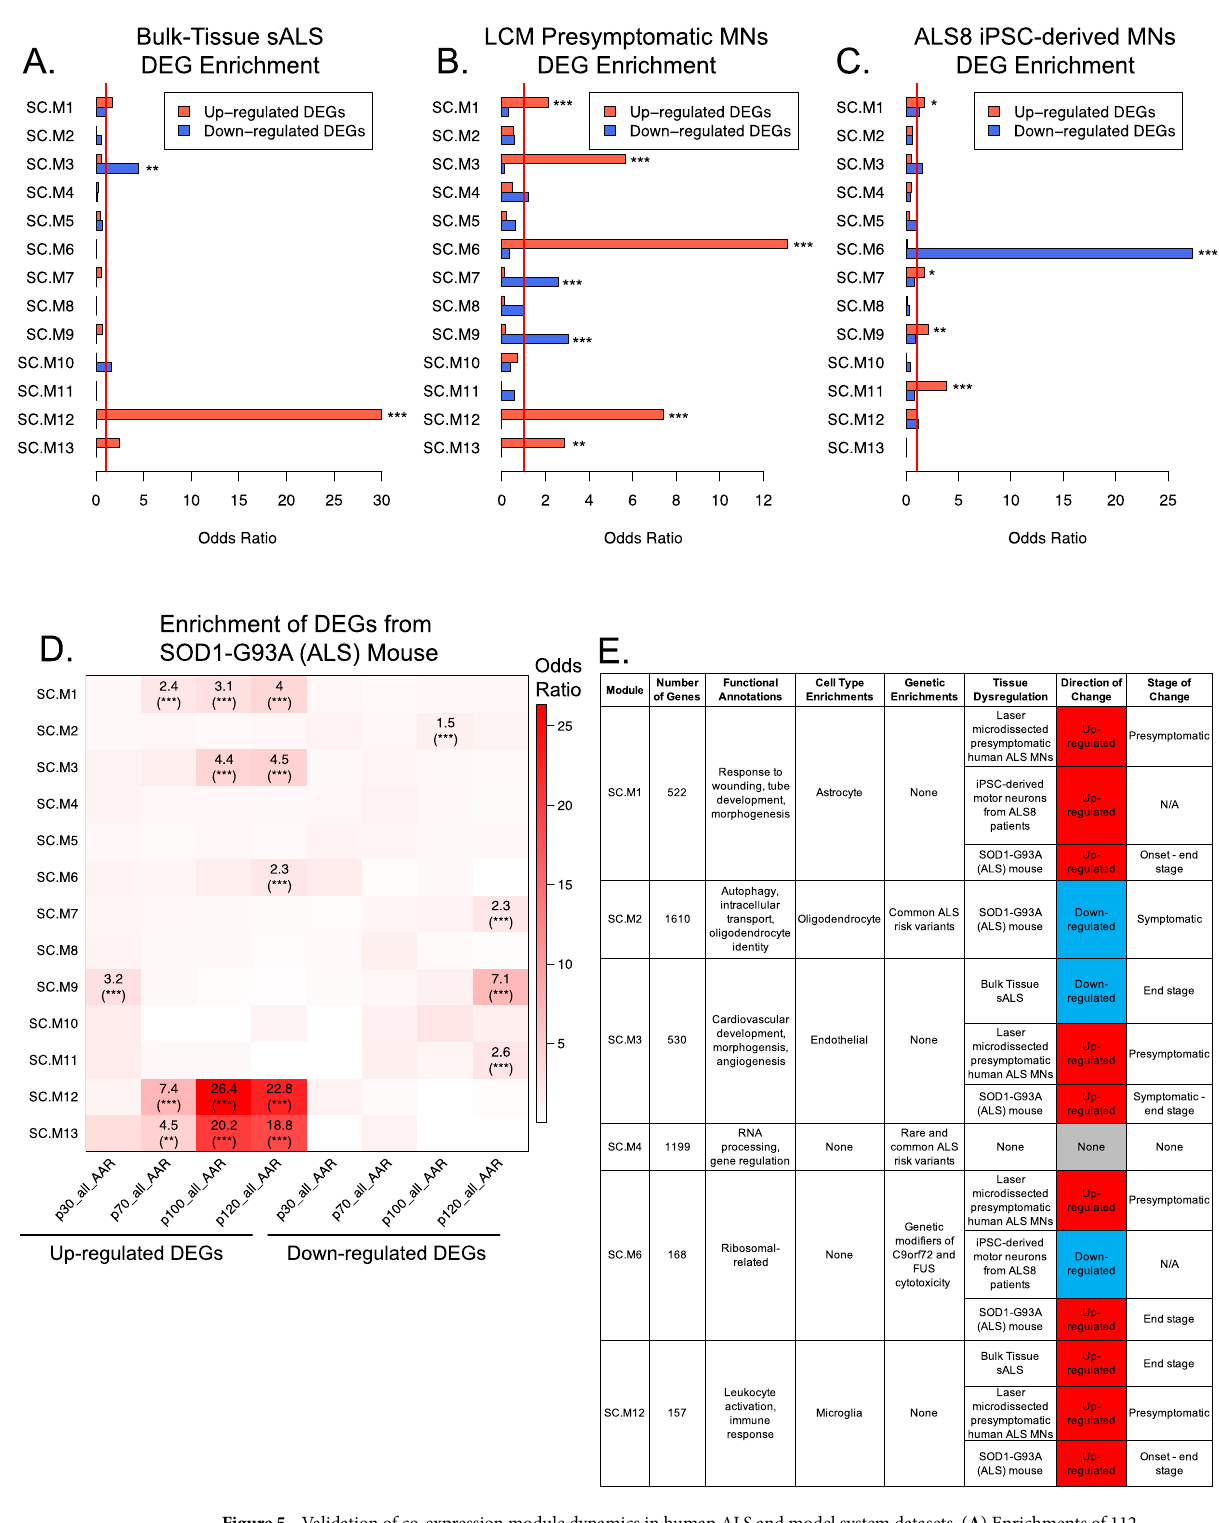
Figure 5. Validation of co-expression module dynamics in human ALS and model system datasets. ( A ) Enrichments of 112 up-regulated and 70 down-regulated DEGs from bulk-tissue RNA-sequencing of postmortem ALS cervical spinal cord 13 within co-expression modules. Red line marks a baseline odds ratio of 1. * (FDR corrected p-value < 0.05). ** (FDR corrected p-value < 0.01). *** (FDR corrected p-value < 0.001). ( B ) Same as ( A ) except for using 1290 up-regulated and 310 down-regulated DEGs from RNA-sequencing of laser capture microdissections of motor neurons primed for degeneration 22 . ( C ) Same as ( A ) except for using 364 up-regulated and 289 down-regulated DEGs from RNA-sequencing of iPSC-derived motor neurons from ALS8 patients 23 . ( D ) Enrichment of DEGs within each disease stage of the SOD1-G93A mouse 12 within co-expression modules. p30, p70, p100, and p120 represent postnatal age in days at time of spatial transcriptomic sequencing. Odds ratios of enrichments with FDR corrected p-value < 0.05 are shown. * (FDR corrected p-value < 0.05). ** (FDR corrected p-value < 0.01). *** (FDR corrected p-value < 0.001). ( E ) Summary of the key findings from this study regarding modules relevant to ALS